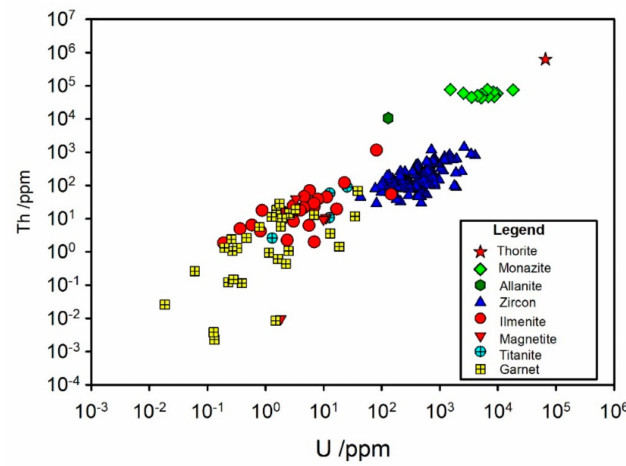
Figure 8. Th and U content of individual mineral